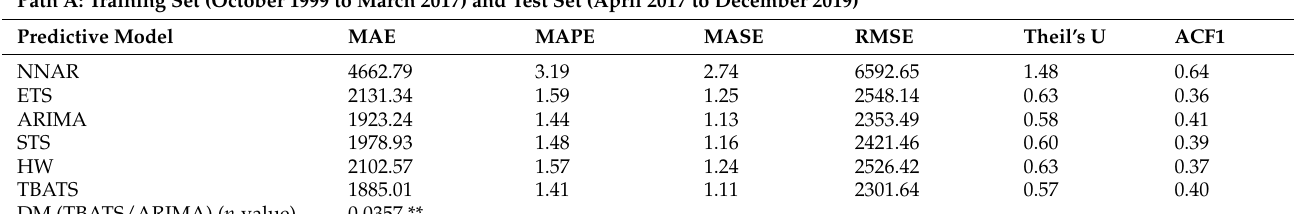
Table 1. Performance metrics for the six models on ECOMSA (path A and path B).